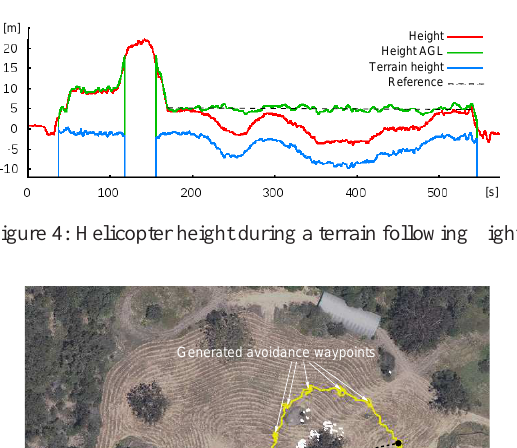
ψ =heading error, v =horizontal/vertical velocity error Table 3: Empirical control error bounds a of basic flight modes.